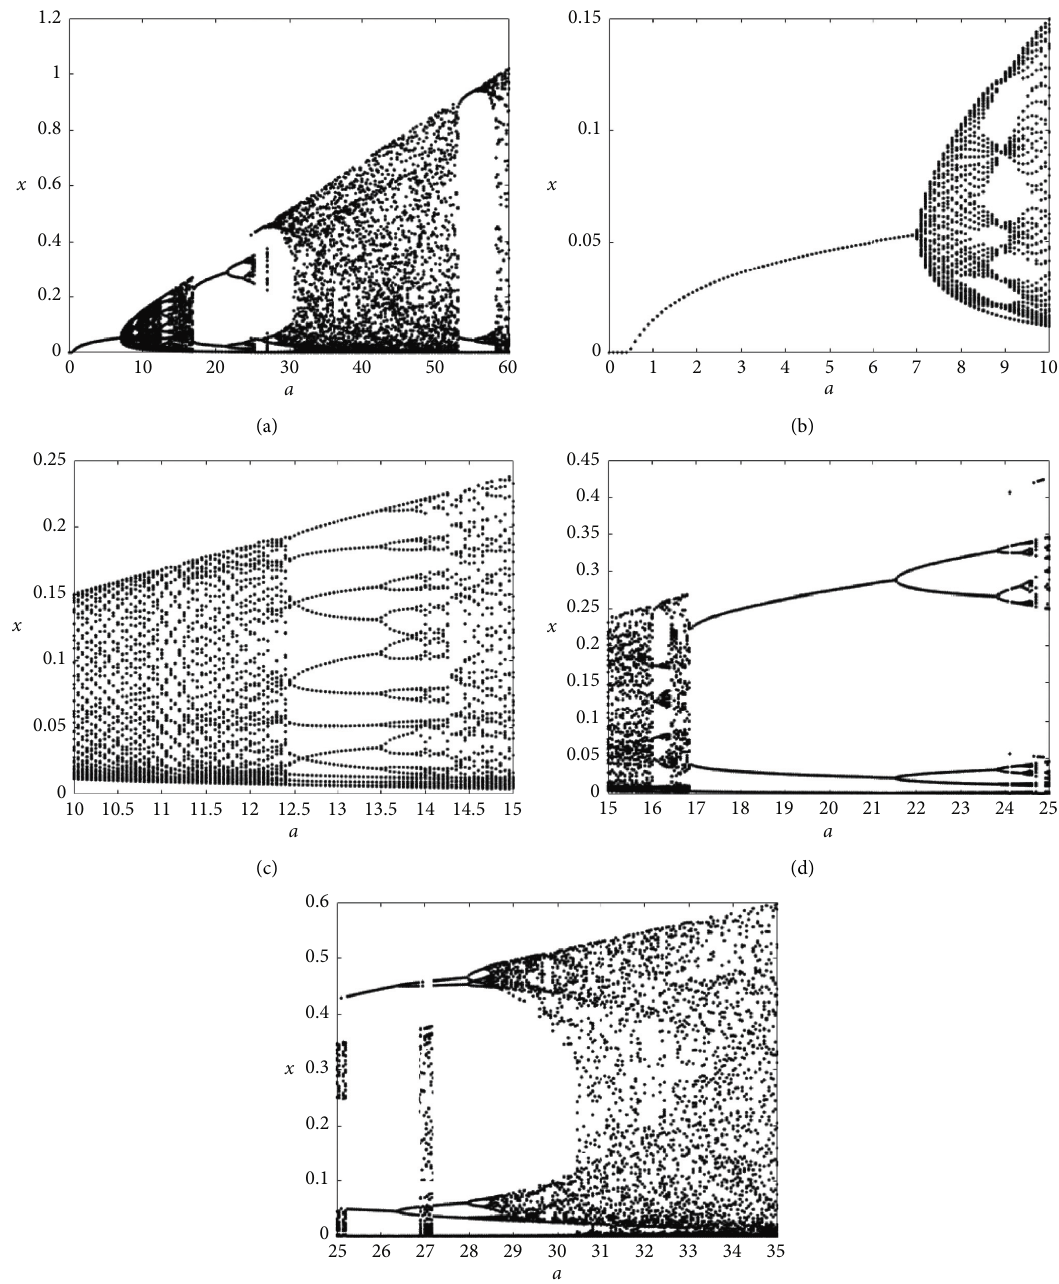
Figure 1: Bifurcation diagrams of the Hassell mapping ( c � 0 . 8 , β � 22, b � 0.7, and 0 < a <